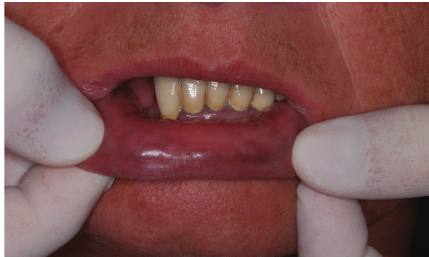
Figure 1: Di ff use macular brown pigmentation on the vermilion of the lower